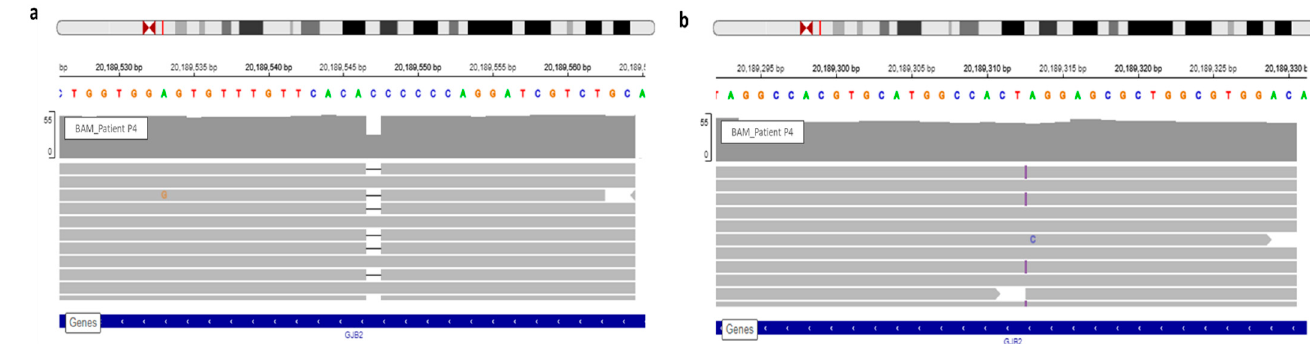
Figure 2. View of GJB2 variants of patient P4 in IGV. ( a ) WGS confirmed the known c.35delG. ( b ) The frameshift variation, c.269dup, detected via WGS and observed in IGV.